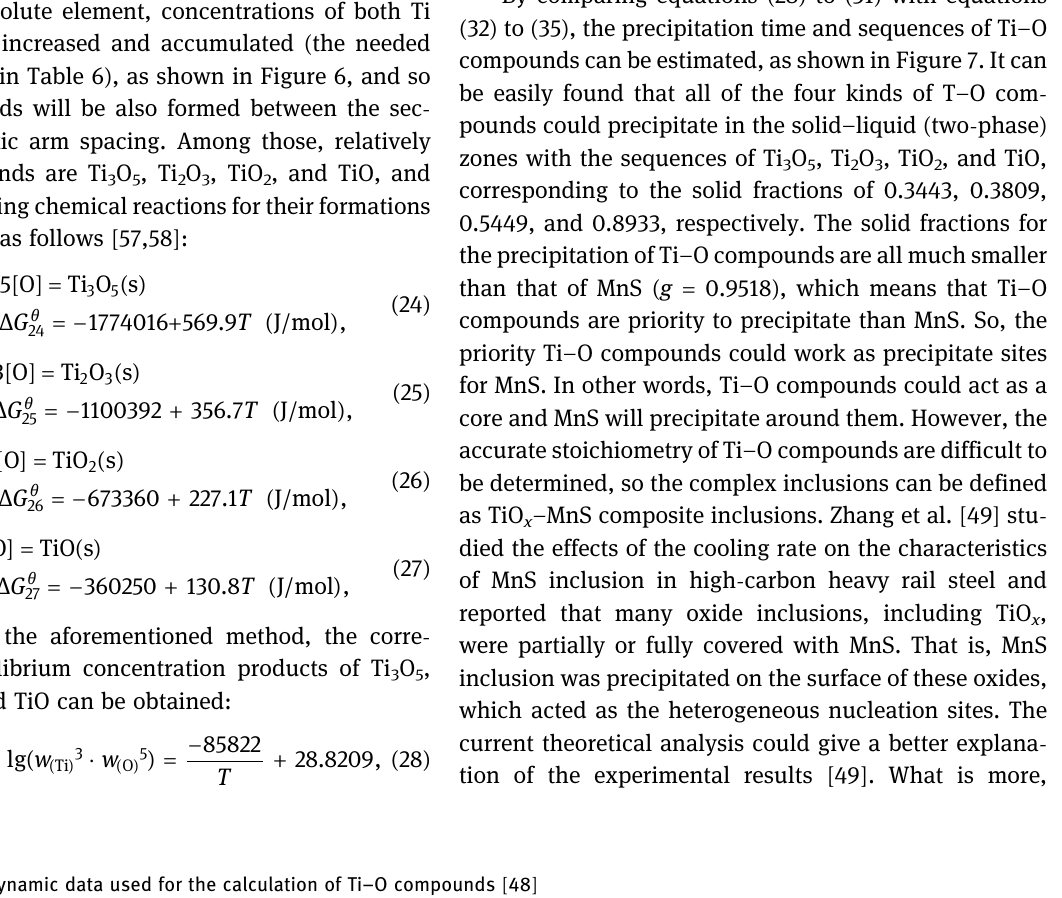
Table 6: Thermodynamic data used for the calculation of Ti – O compounds [ 48 ]